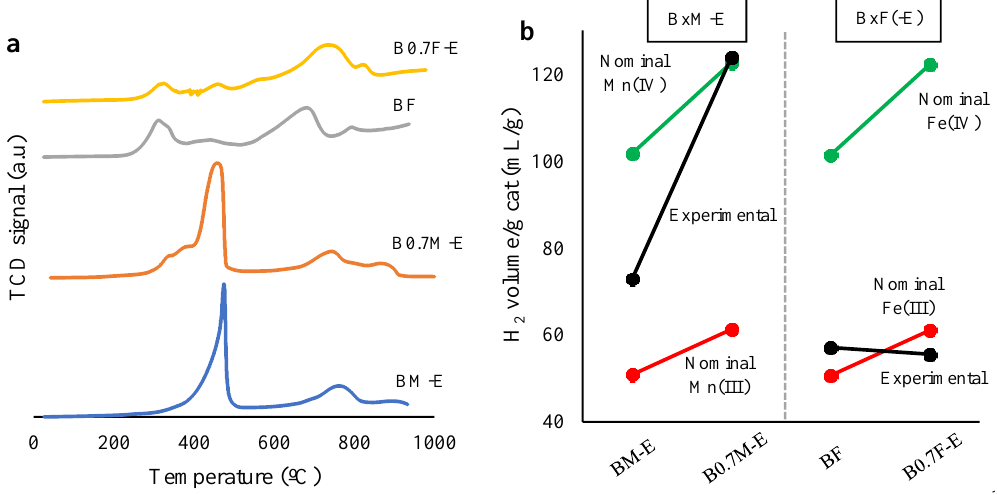
Figure 6. H 2 -TPR consumption profiles for catalysts ( a ) and H 2 consumption (mL/g of catalyst) ( b ).